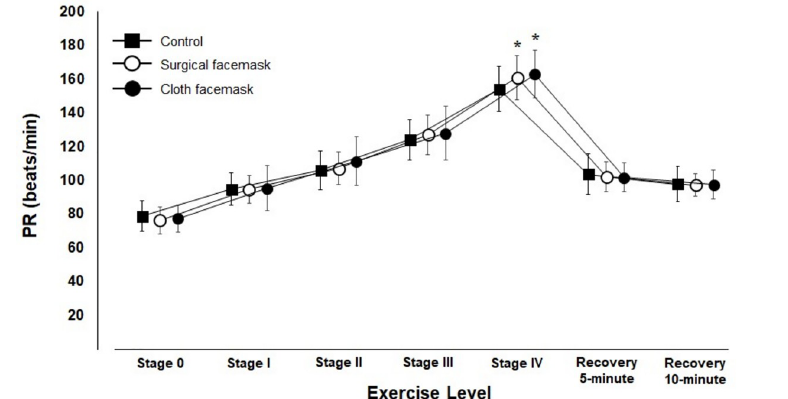
Fig 2. Changes in Pulse Rate (PR) before, during, and after the treadmill walking test.